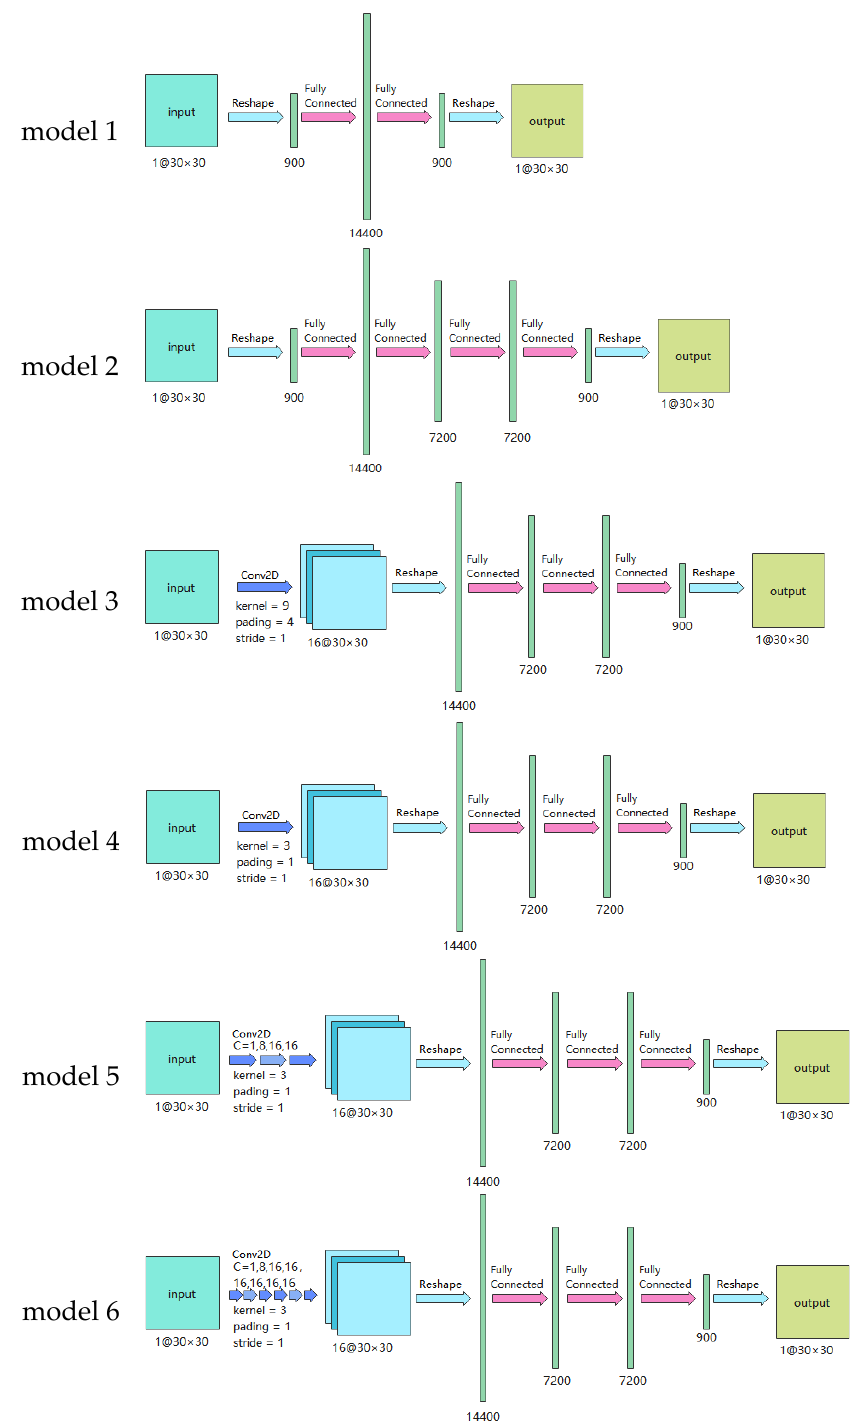
Figure 8. Diagram of each neural network model structure in Group A.